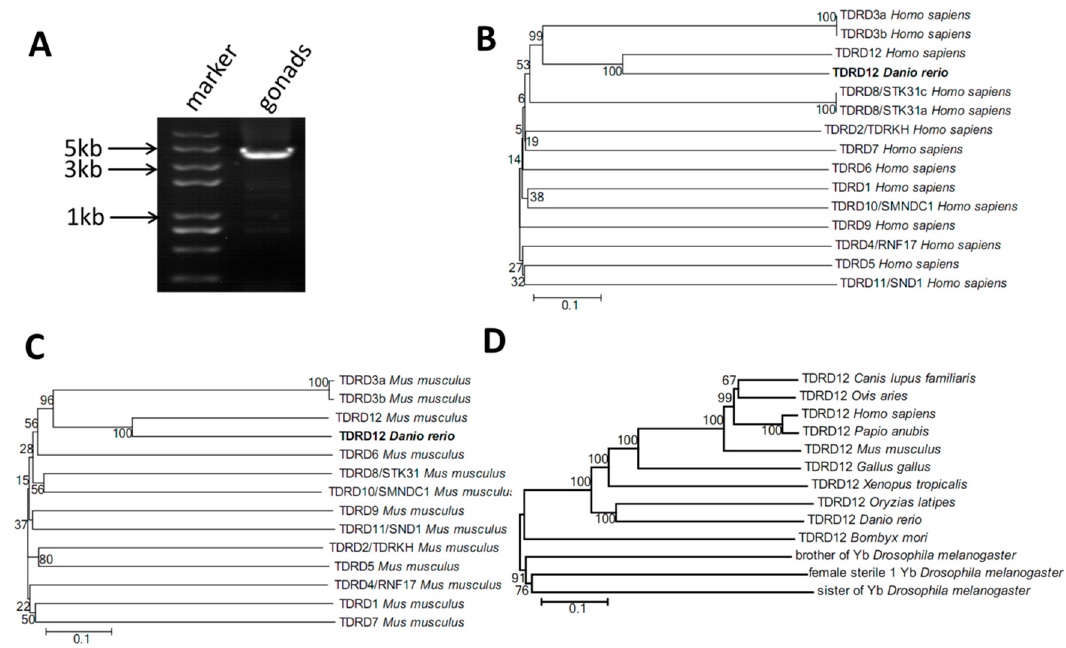
Figure 1. Zebrafish Tdrd12 is conserved across species. ( A ) The full-length coding region of the putative tdrd12 mRNA was amplified from 120-dpf wild-type zebrafish gonadal cDNA samples. The appearance of the amplified fragment showed a PCR product at 4.1 k base pairs in length; ( B ) Phylogeny analysis of the putative zebrafish Tdrd12 protein and human TDRD family protein members. The results indicate that the putative zebrafish Tdrd12 is most homologous to human TDRD12. The TDRD proteins of humans were as follows: TDRD1: NP_942090.1; TDRD2/TDRKH